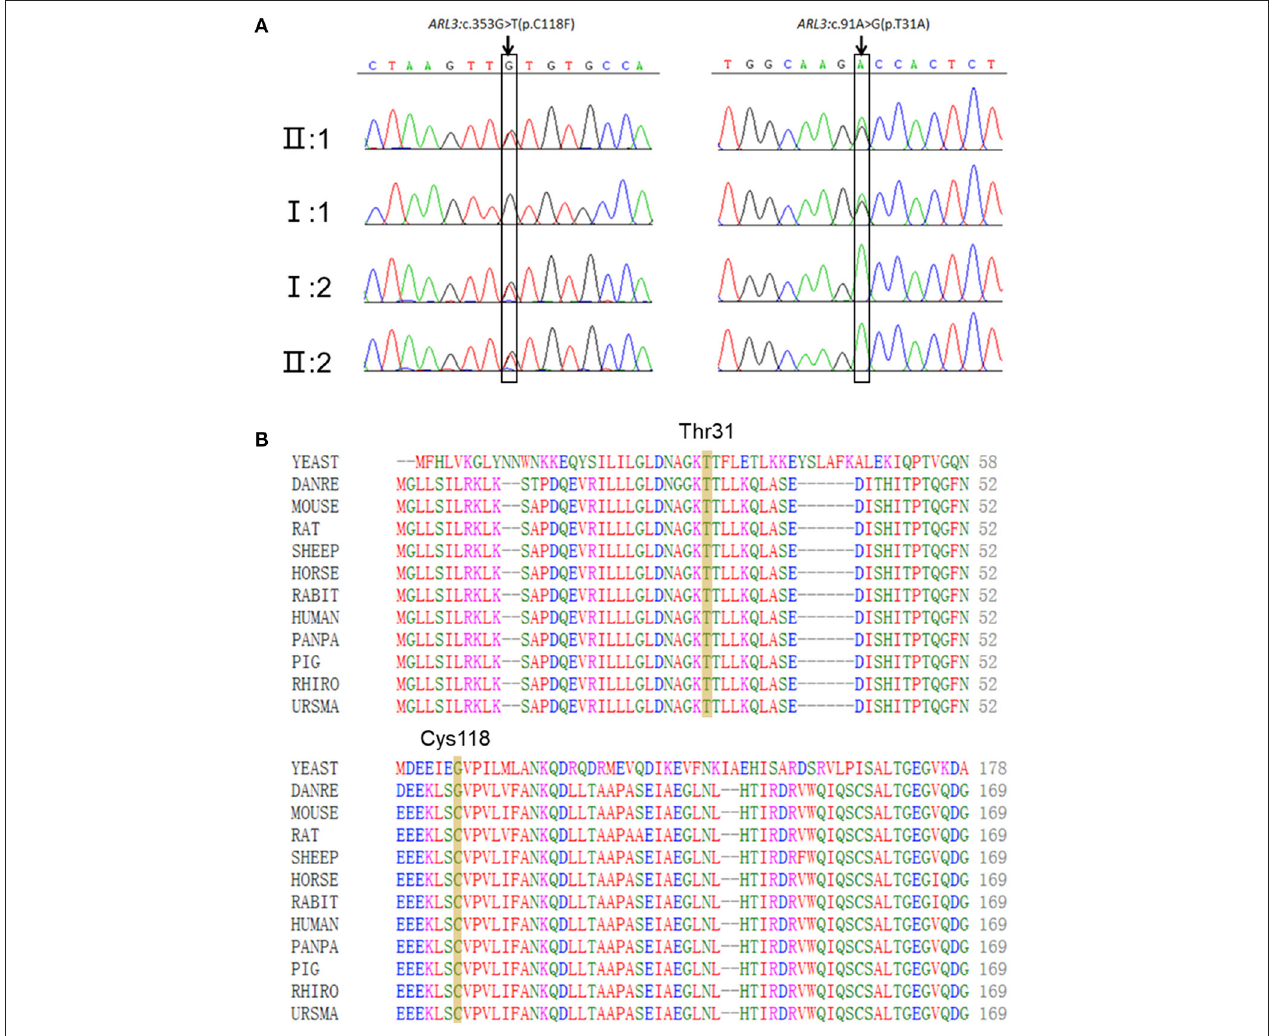
FIGURE 3 | Two novel ARL3 variants (c.91A > G, p.T31A; c.353G > T, p.C118F) were identified in the RCD family. (A) Sanger sequencing in all family numbers. (B) Multiple alignments of Thr31 and Cys118 of ARL3 protein from different species. Both variants occurred on the conserved residues of the ARL3 protein.